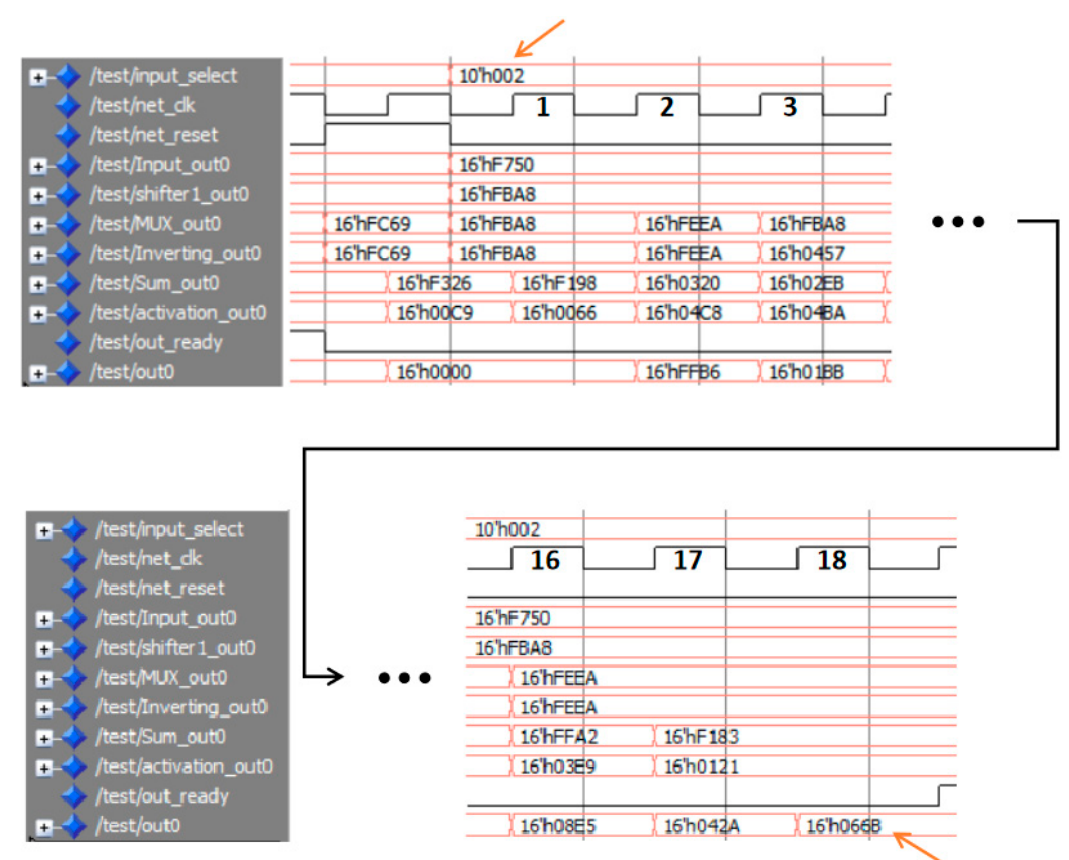
Figure 3. Functional simulation of the field programmable gate array (FPGA)-based implementation of the stochastic configuration network (SCN).